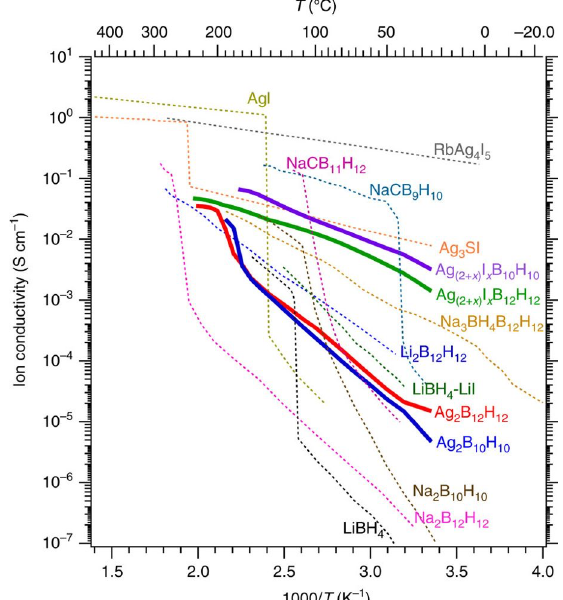
Figure 16. Ionic conductivities measured by Paskevicius et al. for silver dodecaborate and decaborate Ag 2 B 12 H 12 (red) and Ag 2 B 10 H 10 (blue) and the novel iodide substituted variations Ag (2+ x ) I x B 12 H 12 (green) and Ag (2+ x ) I x B 10 H 10 (purple), plotted with comparisons of other related materials [157]. Conductivities are plotted as a function of inverse temperature. Reprinted from